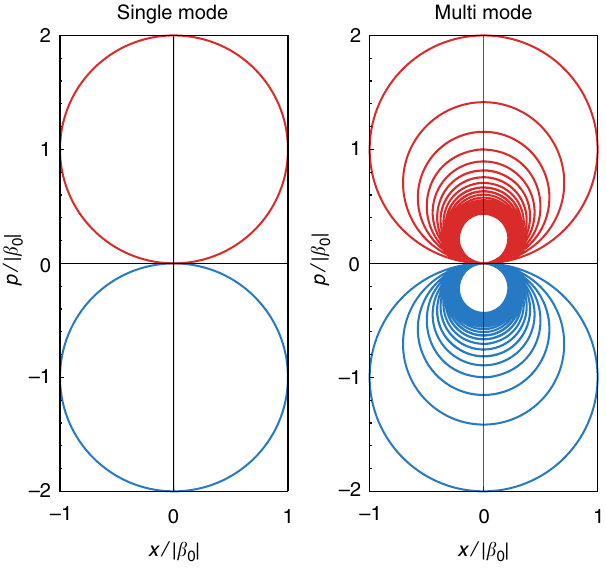
Fig. 3 Phase space trajectories of the cavity modes. Trajectories in phase space for the single-mode case (left) and the multi-mode case (right) in which the trajectories of successive modes are plotted up to n = 20. Red (blue) curves correspond to the trajectories for an initial þj i (cid:2)j ið Þ state